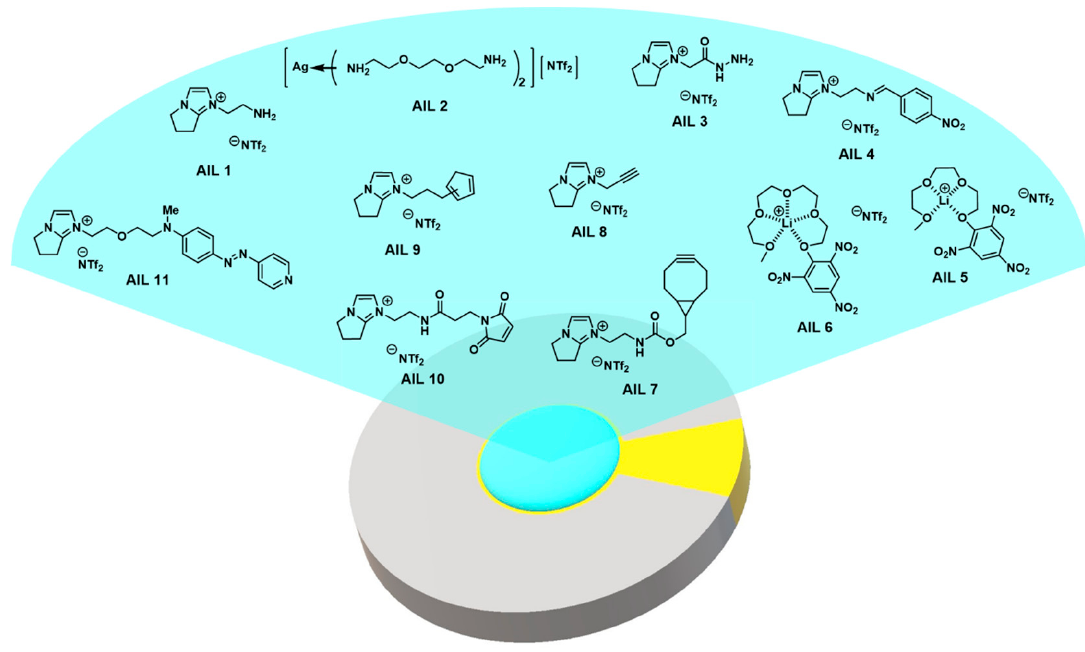
Figure 7. AILs are thin-coated on QCM electrodes for quantitative gas analysis. Here provides the AILs developed by Chu and coworkers for chemical reaction-based gas sensing.